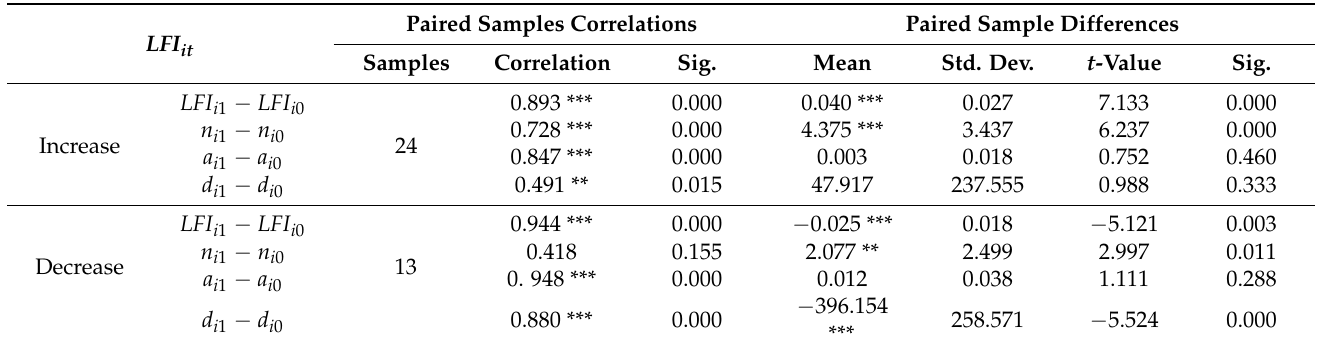
Table 7. Results of paired sample t-test for change of LF degree in scenario